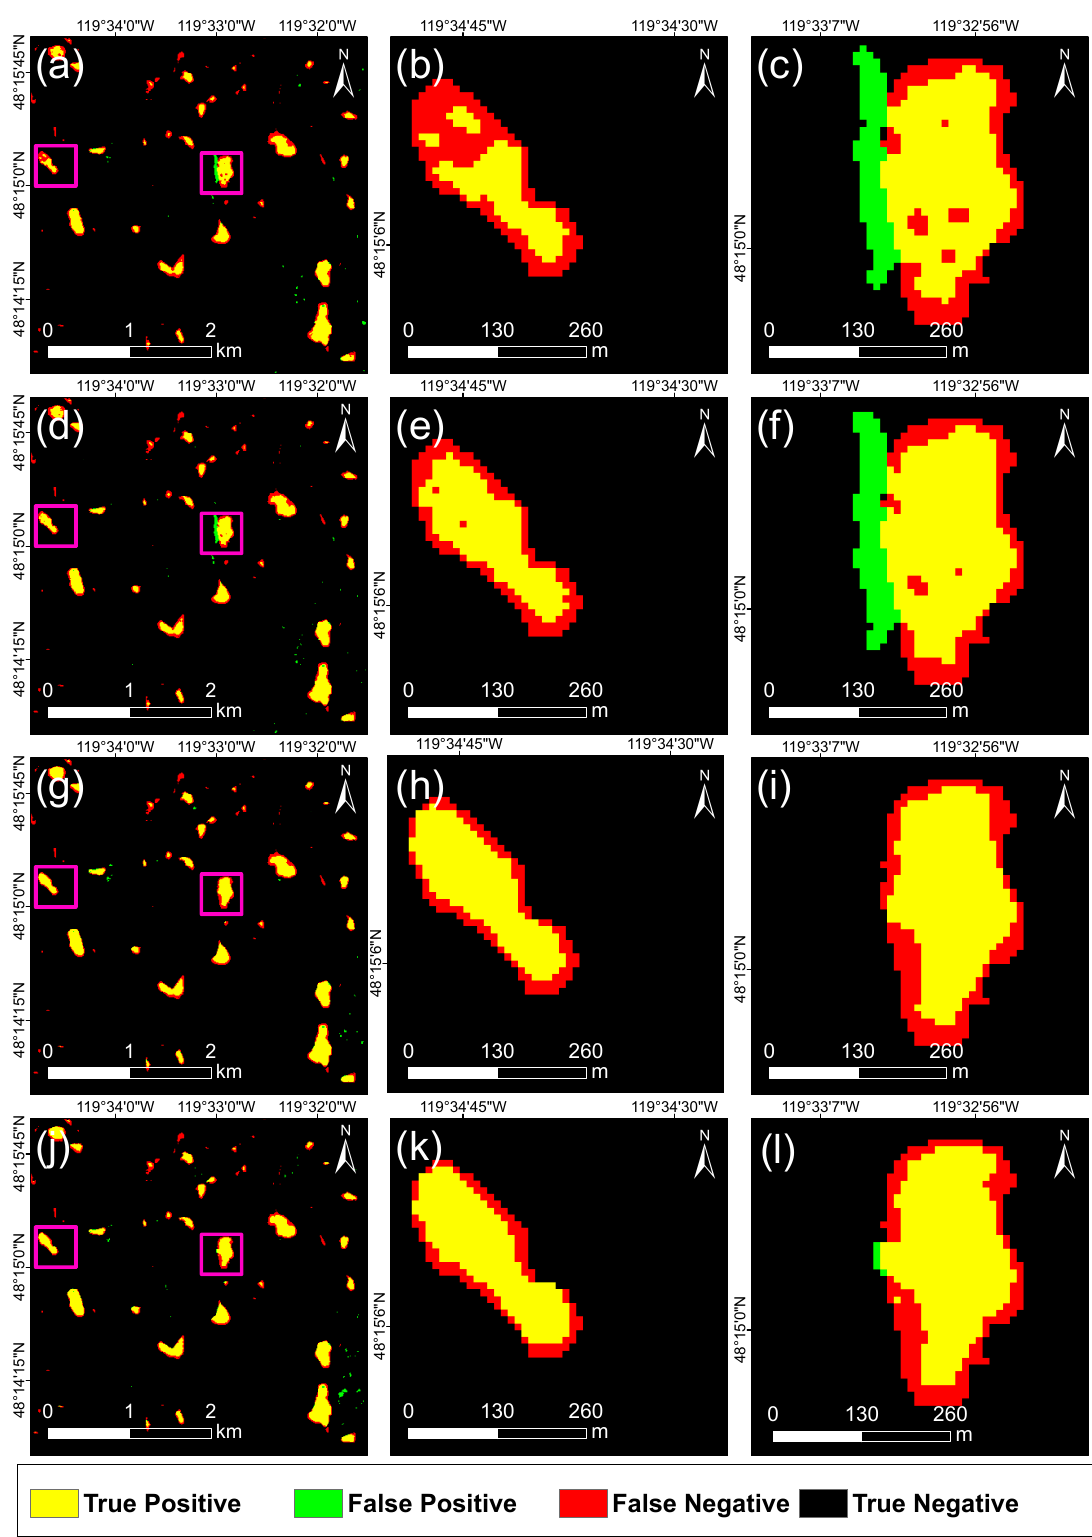
Figure 15. Comparison of the classification results for 22 July 2018, derived from each dataset: ( a ) Dataset-A, ( d ) Dataset-B, ( g ) Dataset-C, ( j ) Dataset-D. Moreover, ( b , e , h , k ) shows that the highlighted area in ( a , d , g , j ) is enlarged. ( c , f , i , l ) shows that the right highlighted area in ( a , d , g , j ) is